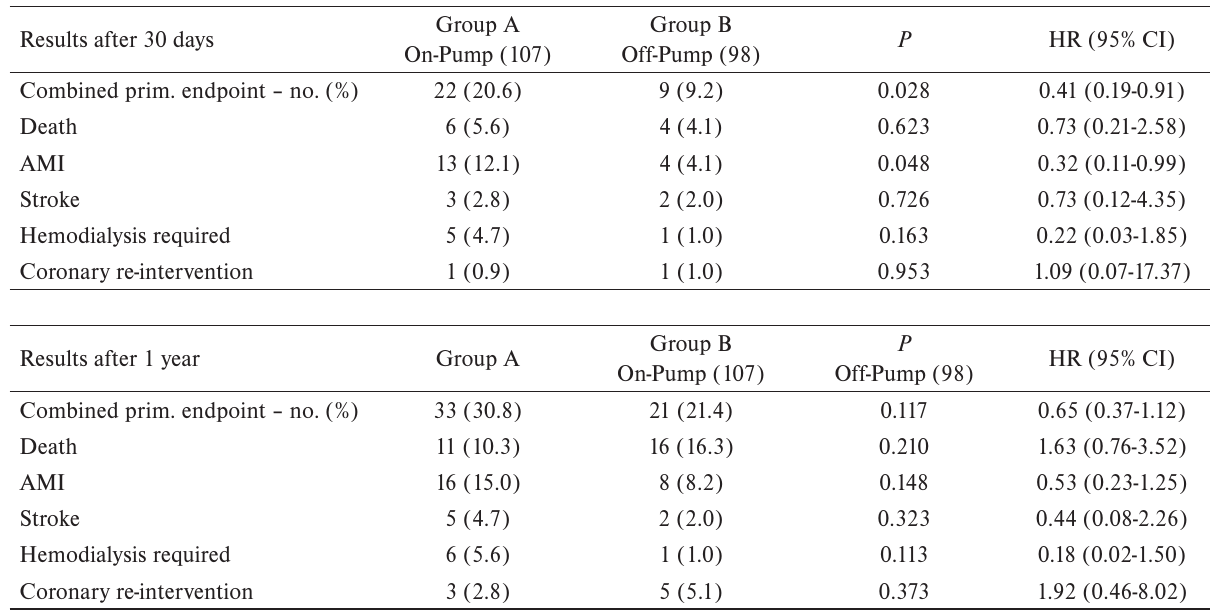
Table 4. Results after 30 days and after 1 year (intention-to-treat) #